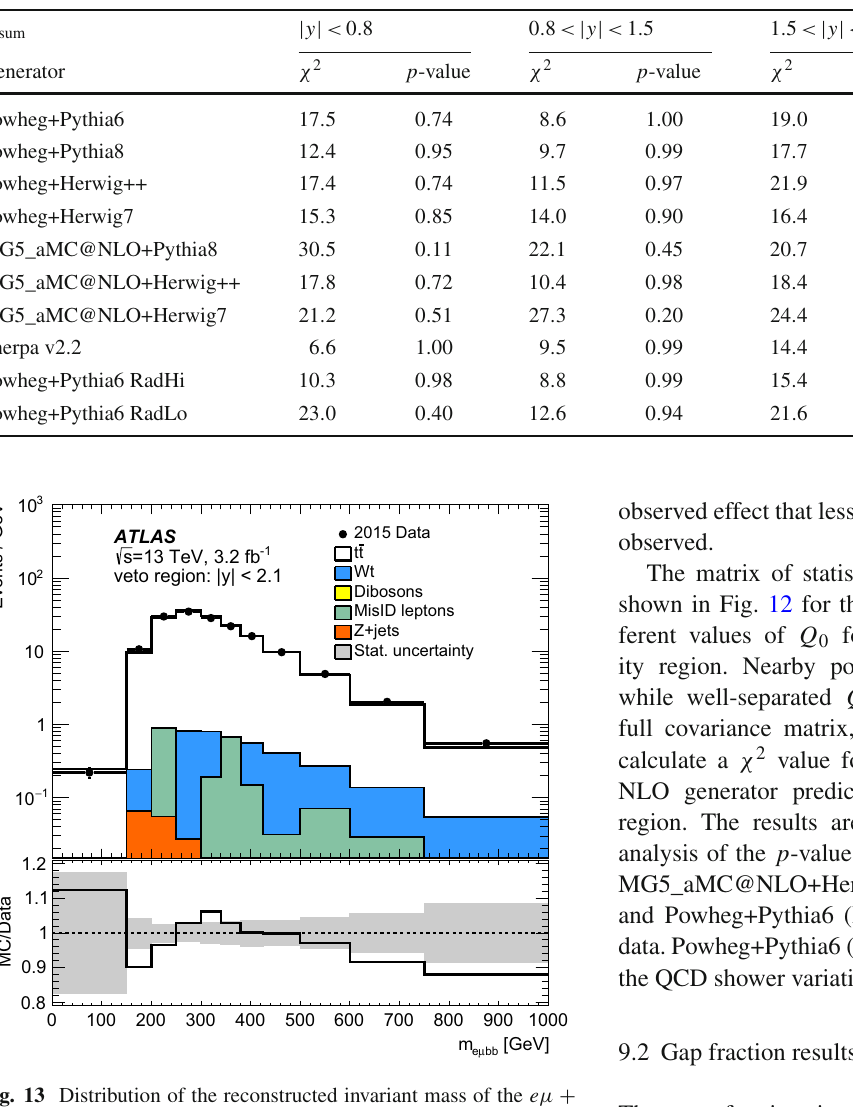
Table 13 Values of χ 2 for the comparison of the measured gap fraction distributions with the predictions from various t ¯ t generator configurations, for the four rapidity regions as a function of Q sum . The χ 2 and p -values correspond to 22 degrees of freedom